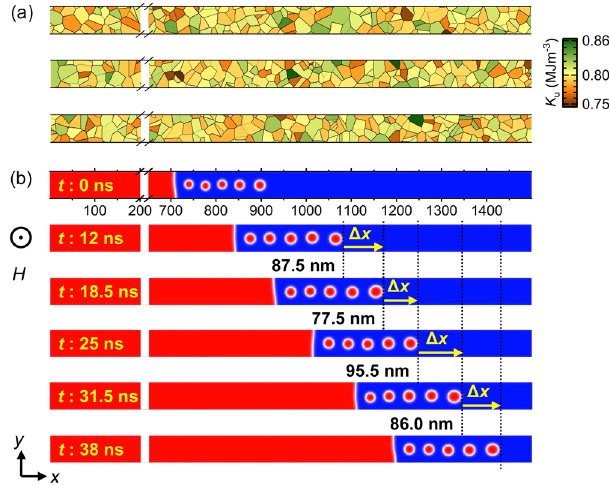
Fig. 5 Field-driven dynamics of a domain wall – skyrmions train in granular nanotrack. a Three different realizations of the granular nanotrack with an average grain size of 20 nm by Voronoi tessellation. In each grain, the strength of perpendicular magnetic anisotropy K u is randomly distributed around the average value K u0 = 0.8 MJm − 3 with a Gaussian distribution of the deviation Δ K ( = K u ‒ K u0 ). In this fi gure, Δ K = 2% K u0 is shown. The color code indicates the strength of K u . b Under fi eld strength H = 300 Oe, the ensemble can move, without pinning, in the sample with Δ K = 2% K u0 ( K u0 = 0.8 MJm − 3 and Dzyaloshinskii-Moriya interaction strength D = 3.5 mJm − 2 ). However, different from in the clean sample, the ensemble travels different distances Δ x over the same time intervals Δ t . Accordingly, we derive the average ensemble velocity by fi tting the positions against